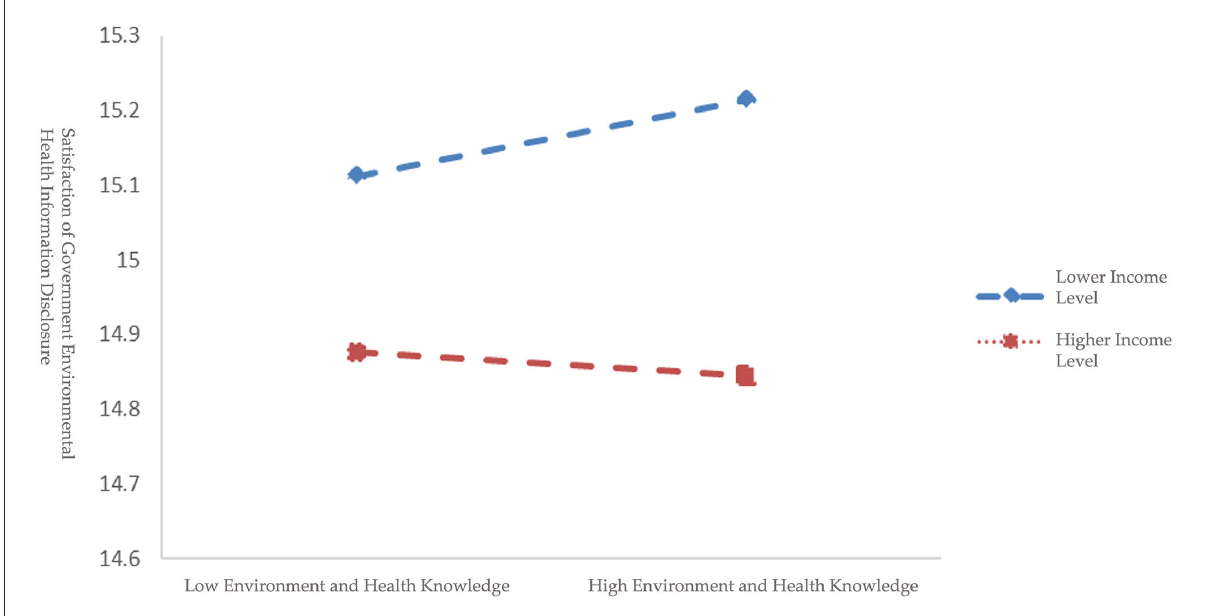
FIGURE2 Moderating effect of income level between environmental health knowledge and satisfaction of government environmental health information